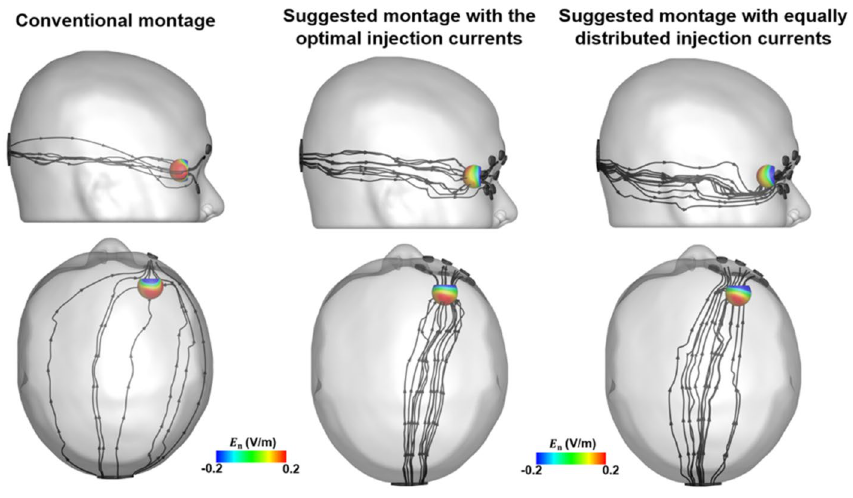
Figure 6. Illustration of streamlines and the distributions of electric fields on the retinal surface for three different conditions (conventional montage, suggested montage with the optimal injection currents, and suggested montage with equally distributed injection